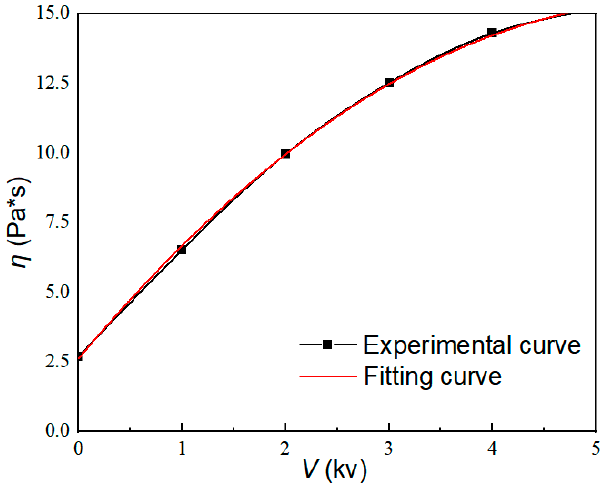
Figure 9. Relationship between viscosity and voltage.